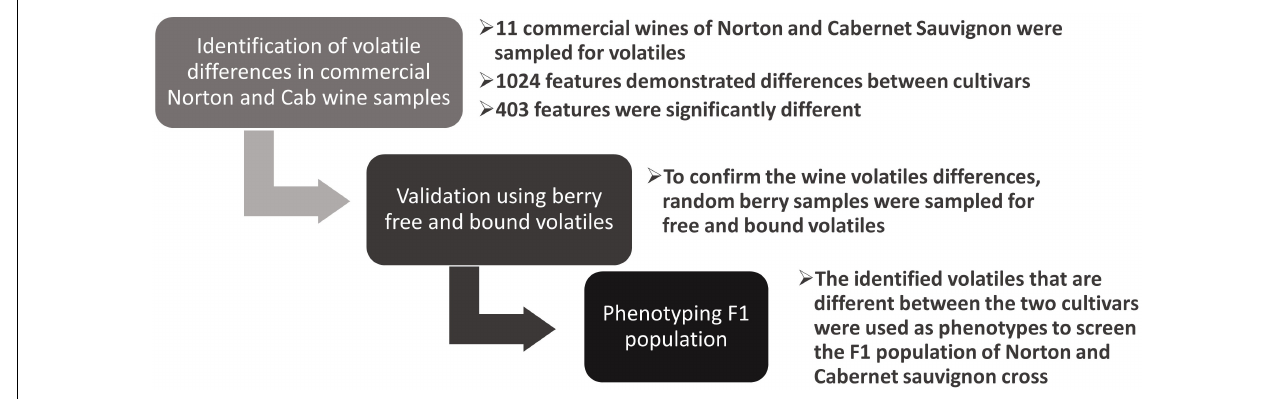
FIGURE 1 | Research workflow: step 1: the supermarket bought commercial wines were phenotyped to identify differences in volatiles, step 2: the random berry samples of the cultivars were phenotyped for free and bound volatiles to confirm the differences in wine, step 3: using the confirmed compounds in both wines and berries, the F1 population of Norton and Cab were